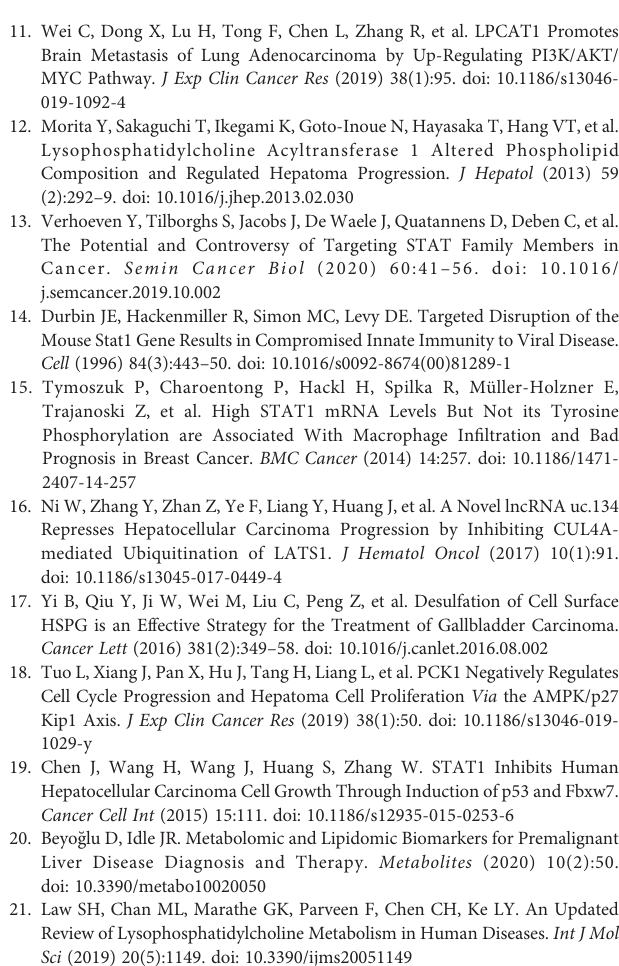
Supplementary Figure 1 | Cellular immuno fl uorescence was used to observe EGFP positive HCC cells at 72 h after infection with lentiviral vectors mediating LpCat1 overexpression or knockdown. Supplementary Figure 2 | qRT-PCR analysis of LpCat1 expression in HCC tissues and corresponding normal tissues (n=40). Supplementary Figure 3 | The expression level of STAT1 was detected by tissue microarray-based immunohistochemical analysis in HCC tissues. The representative images of STAT1 expression in HCC tissues and corresponding normal live tissues by IHC were taken, scale bar = 50